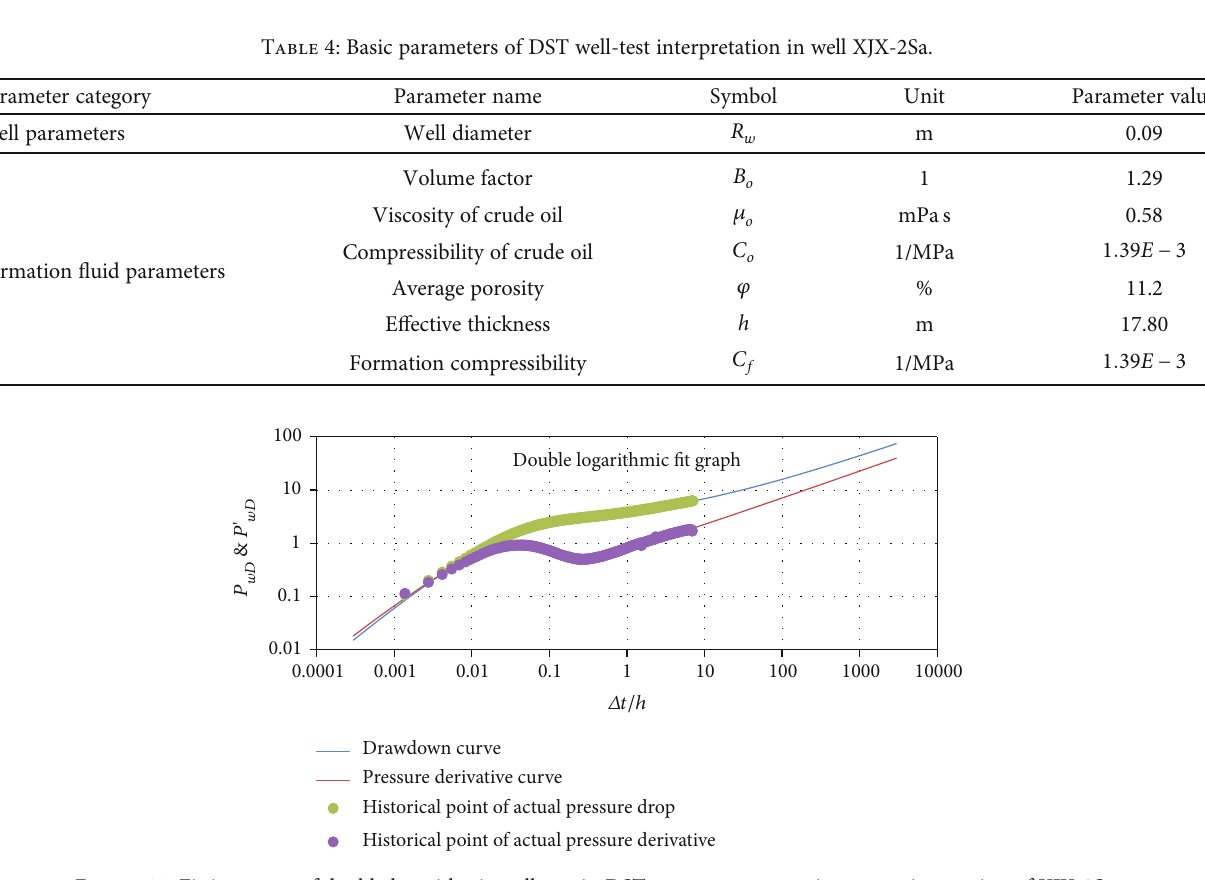
Figure 17: Fitting curve of double logarithmic well-test in DST pressure recovery interpretation section of XJX-2Sa. Table 5: Result interpretation table of the XJX-2Sa